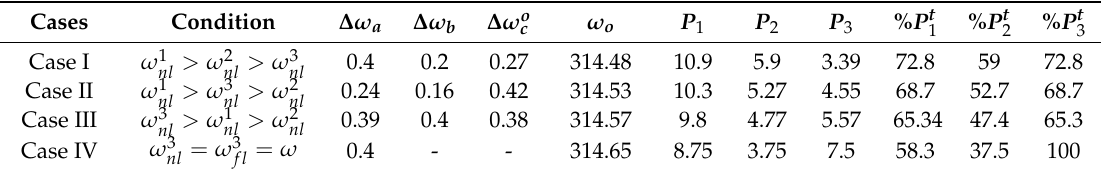
Figure 11. Power and Frequency Trend Case I. Table 5. Parameters of a multi-VSG microgrid.